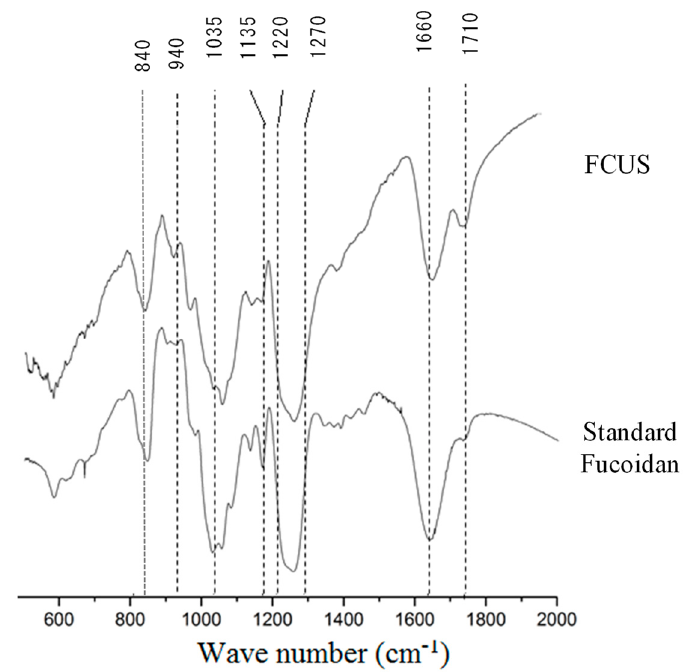
Figure 1. FT-IR spectra of FCUS and standard commercial fucoidan. FCUS and standard fucoidan were scanned between 600–2000 cm − 1 .